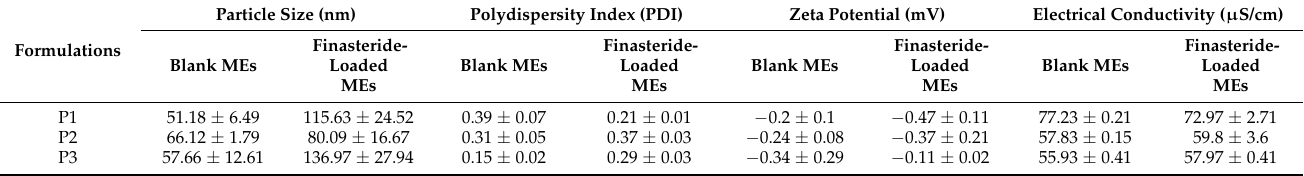
Table 3. Particle sizes, zeta potentials, polydispersity indices (PDI), and electrical conductivities of microemulsions without finasteride (blank ME) and finasteride-loaded microemulsions (finasteride- loaded